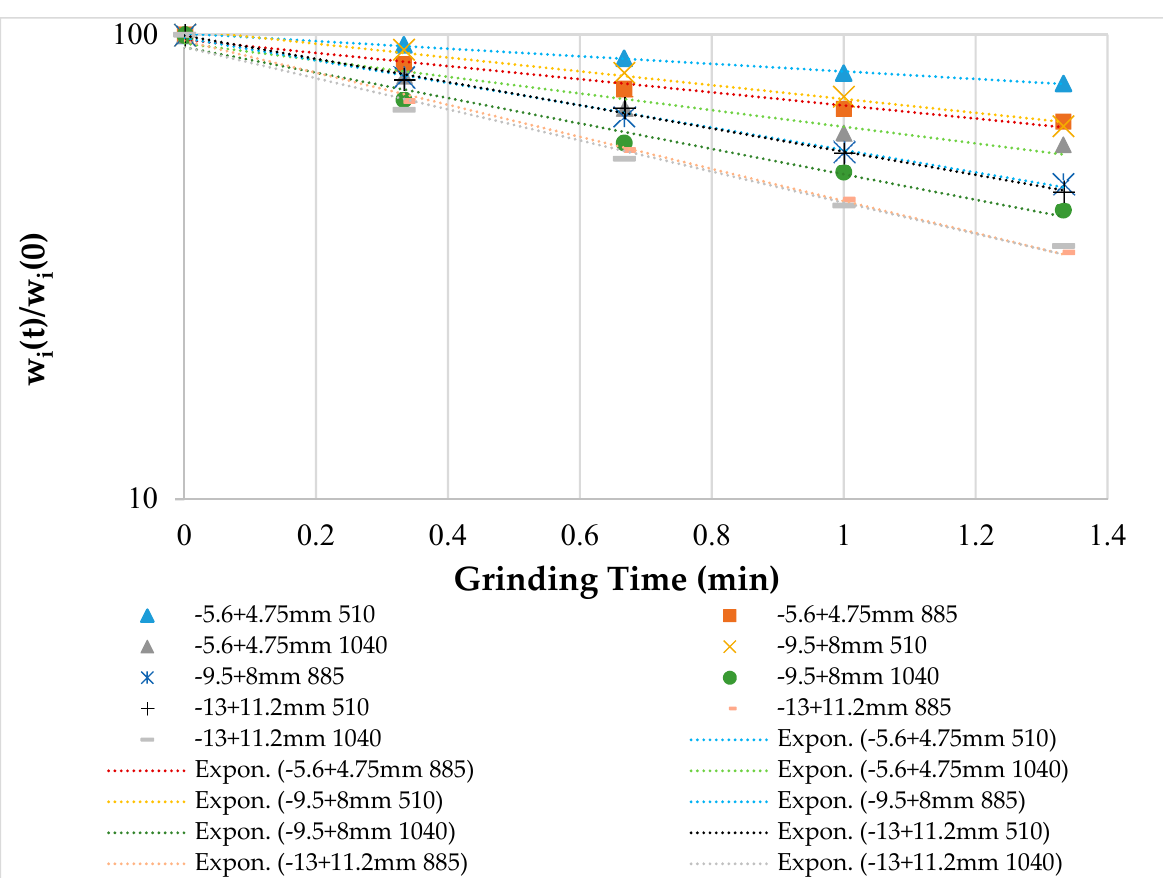
Figure 3. First-order plots for various size fractions ground at 510 rpm, 885 rpm, and 1040 rpm.